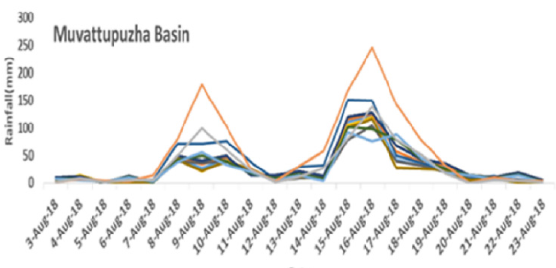
Figure 9. Daily rainfall from IMD data for various sub- watersheds of Muvattupuzha basin. In-direct comparison between simulated dam catchment flows (figure 7) and observed water levels (figure 8) revealed that there water level was at maximum levels during the flood peak occurrence as well as it remained high after few days from peak flood events due to sustained flows from upstream catchments.